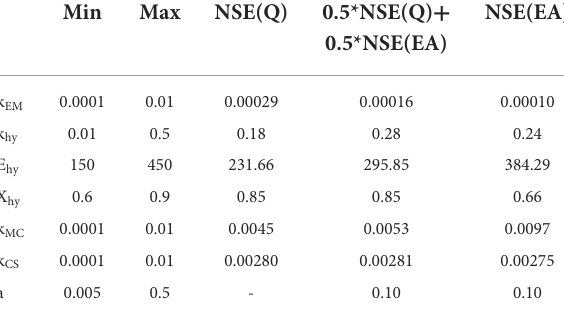
TABLE 2 Parameter space and values for the parameters estimated with a Particle Swarm Optimization (PSO) procedure implemented in the “pyswarm” package (Lee, 2014) according various objective